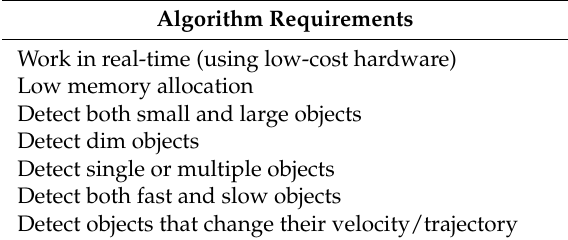
Table 1. List of the requirements the proposed algorithm should